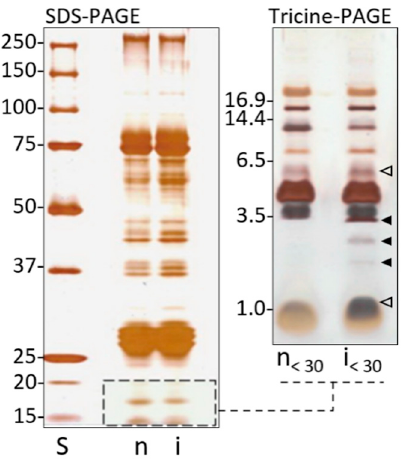
Figure 2. Analytical electrophoresis of hemolymph from not infected (n) and infected (i) B. mori larvae. On the left: SDS-PAGE (10%) of 30 μ g/well (total proteins) of whole hemolymph. On the right, samples were analyzed by 16% Tricine-PAGE. Full arrowheads indicate low molecular weight inducible components newly synthesized after infection; empty arrowheads indicate quantitatively inducible low molecular weight components increased after infection. S: standard molecular